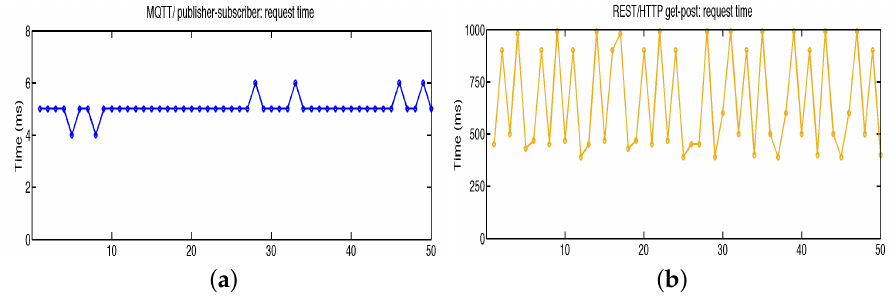
Figure 9. Response time ( a ) Messages using MQTT server on control processes; ( b ) HTTP requests using cloud web server on graphical data